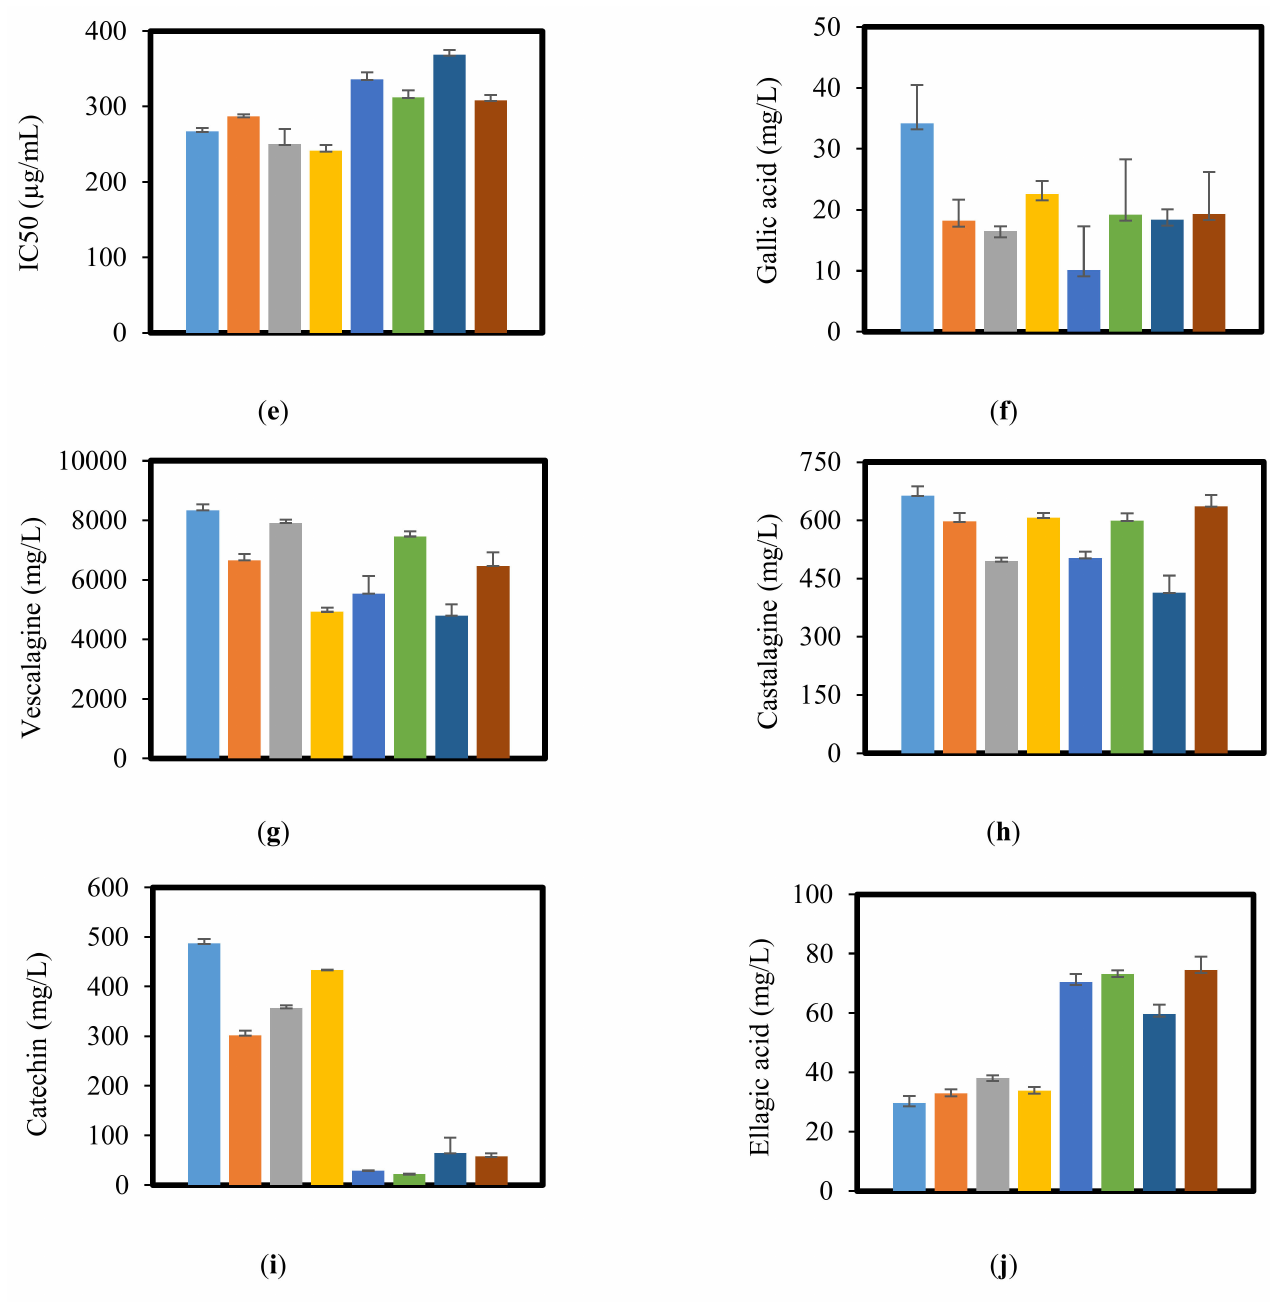
Figure 4. Chemical composition of phenolic extracts from Quercus leaves grown with allelopathic root exudates and Phytophthora cinnamomi infection. ( a ) Total phenols (TPC), ( b ) total tannins (TTC), ( c ) condensed tannins (CTC), ( d ) antioxi- dant activity (AA), ( e ) the half maximal inhibitory concentration (IC 50 ) and the major low molecular weight compounds in phenolic extracts ( f ) gallic acid, ( g ) vescalagine, ( h ) castalagine, ( i ) catechin and ( j ) ellagic acid. Means are shown ± standard